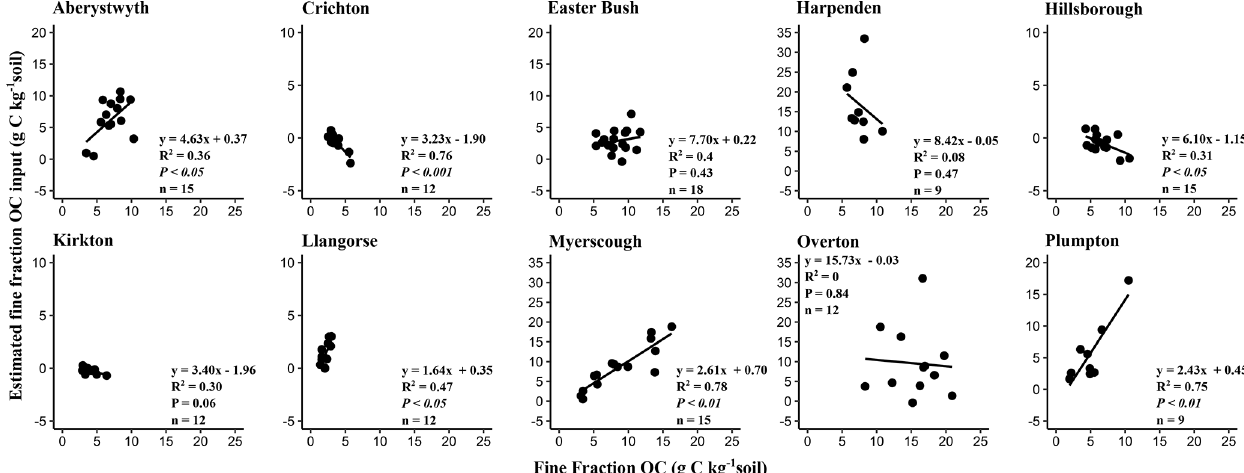
Figure A1. Estimated fine-fraction OC input (gC per kg soil) compared to measured fine-fraction OC (gC per kg soil) in each of the sites studied. The estimated fine-fraction OC input (gC per kg soil) was calculated by subtracting the maximum fine-fraction OC (gC per kg soil) from the current fine-fraction OC (gC per kg soil). The maximum fine-fraction OC (gC per kg soil) was estimated using the quantile regression equation ( τ = 0 . 90), where maximum fine-fraction OC equals 0.92 multiplied by the mass proportion fine fraction